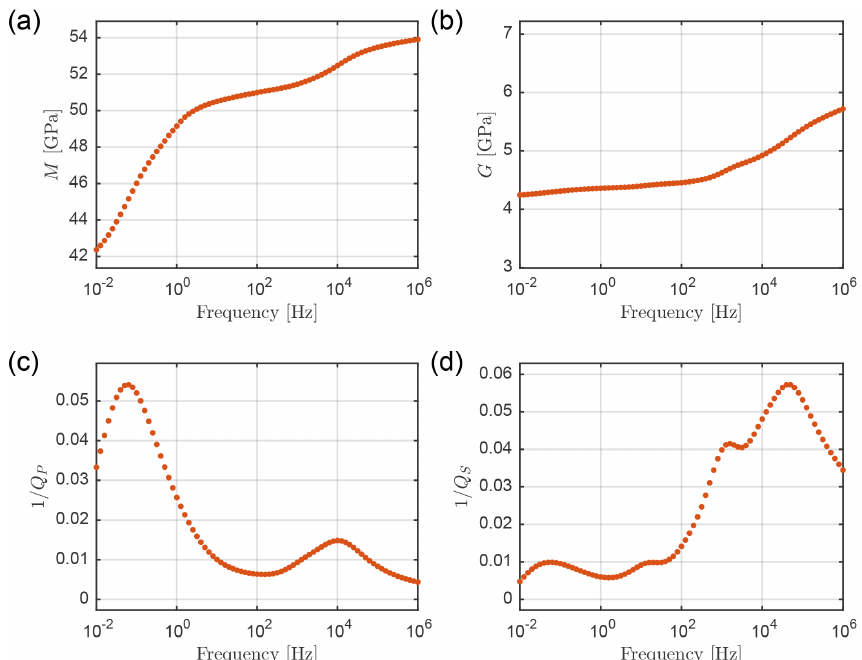
Figure 11. P-wave modulus (a) , S-wave modulus (b) , inverse P-wave quality factor (c) , and inverse S-wave quality factor (d) , modeled for a fractured rock with the geometry shown in Fig. 8, and fracture and intact-rock properties corresponding to those of lithology B at a lithostatic stress of